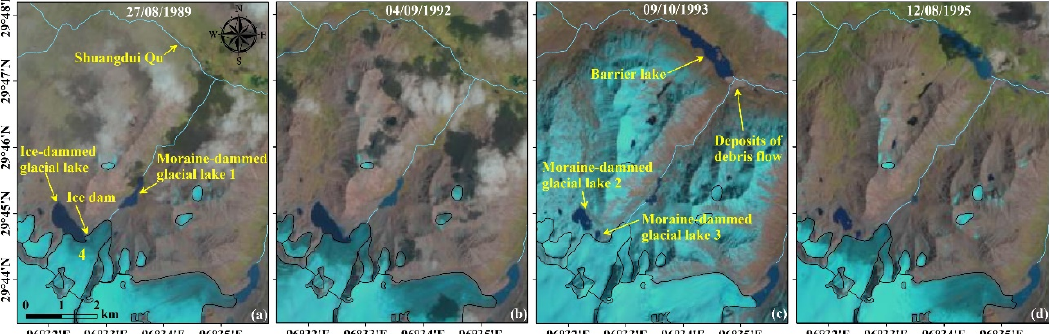
Figure 6. Development of glacial lakes surrounding glacier 4. The backgrounds of ( a – d ) are Landsat-5 images. The acquisition dates of the images are marked on the top of the panels. Black curves denote glacier outlines. Readers can find the location of the shown area by referring to the location of glacier 4 in Figure 1.